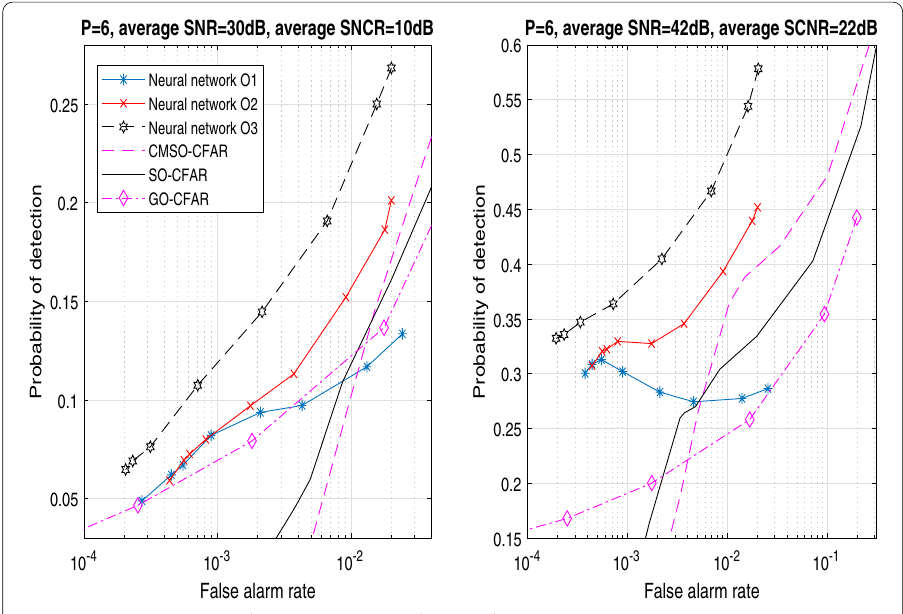
Fig. 12 Receiver operating characteristic curves, clutter and noise